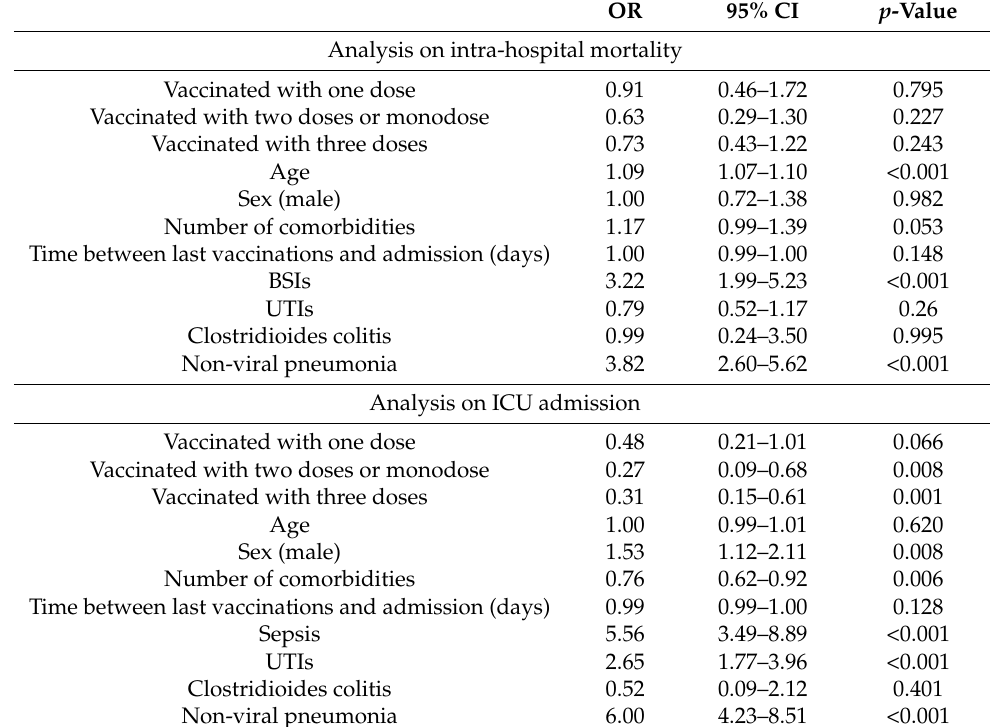
Table 2. Multivariable logistic regression analysis of factors associated to death and ICU